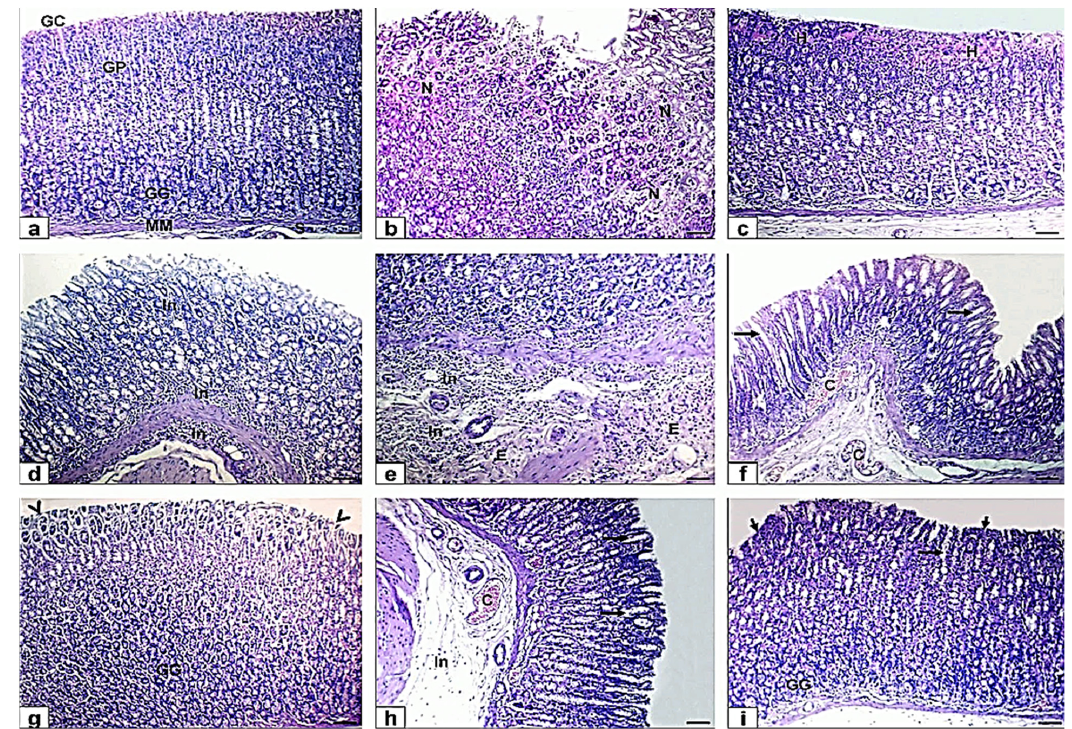
Figure 2. Photomicrographs of gastric sections stained with H&E in ethanol and ethanol-pretreated groups with myrrh extract (ME-EtOH)) and myrrh oil (MO-EtOH). ( a ) The normal control rats showed normal gastric mucosa, gastric cavity (GC), gastric pit (GP), gastric gland (GG), muscularis mucosa (MM), and submucosa (S). ( b – e ) Ethanol-induced ulcer in rats in one hour showing severe coagulative necrosis (N), hemorrhage (H), mononuclear cells infiltration, and aggregation (In) in all layers of gastric mucosa, and excessive edema (E) in the submucosa. ( f , g ) MO-pretreated rat showing dilated and wide gastric pits (long arrows), dilated congested blood vessels (C), and disruption to the surface epithelium (arrowheads). ( h , i ) ME-pretreated rat showing dilated gastric pits (long arrows), congested blood vessels (C) and intact appearance of histological structure of the epithelium (short arrows), gastric gland (GG), and mucosa layer. Scale bar= 100 µm.